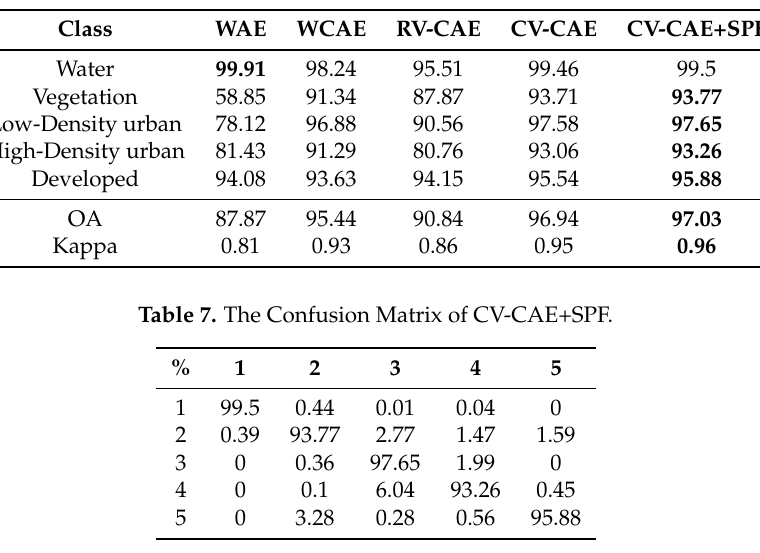
Table 6. The OA and Kappa Coefficient of Our Algorithms and the Compared Algorithms.